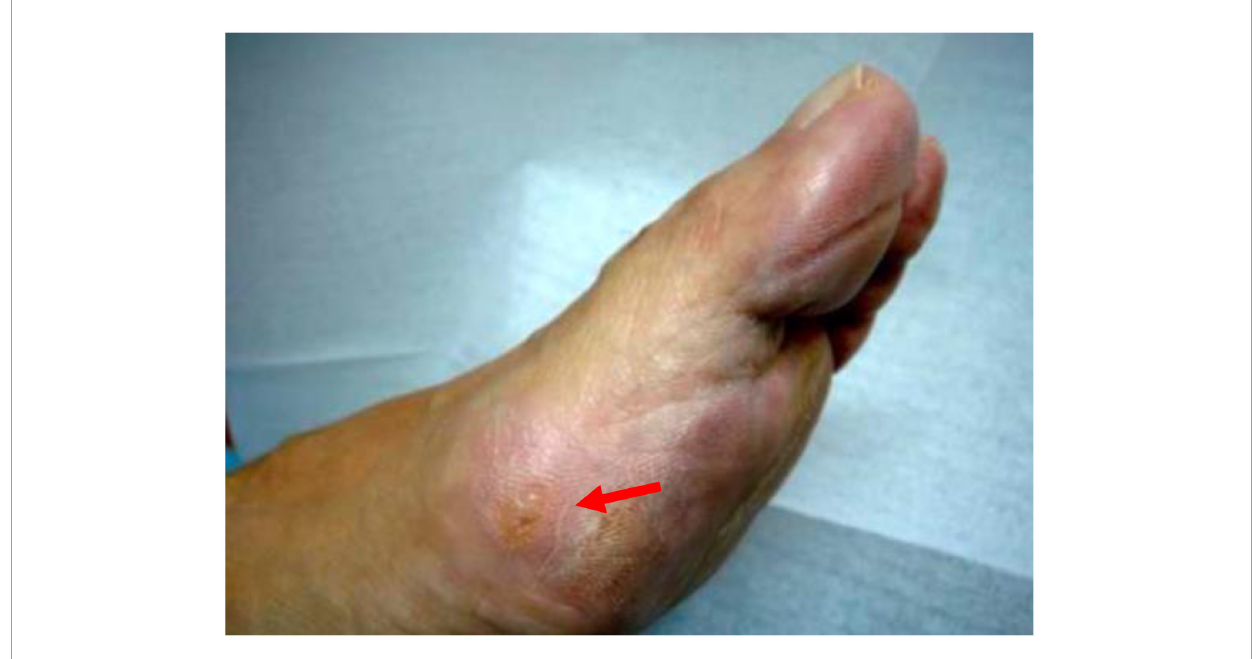
FIGURE1 Hyperkeratosis in 1st metatarsophalangeal (MTP)